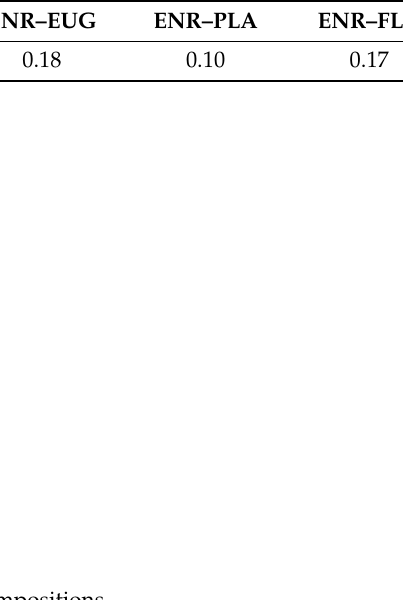
Figure 4. Aging coefficients of studied ENR-based compositions. Table 1. Aging coefficients (K) of studied ENR-based compositions.